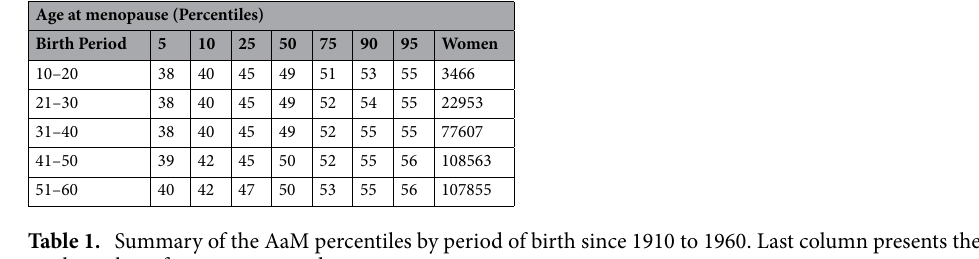
Table 1. Summary of the AaM percentiles by period of birth since 1910 to 1960. Last column presents the total number of women screened.